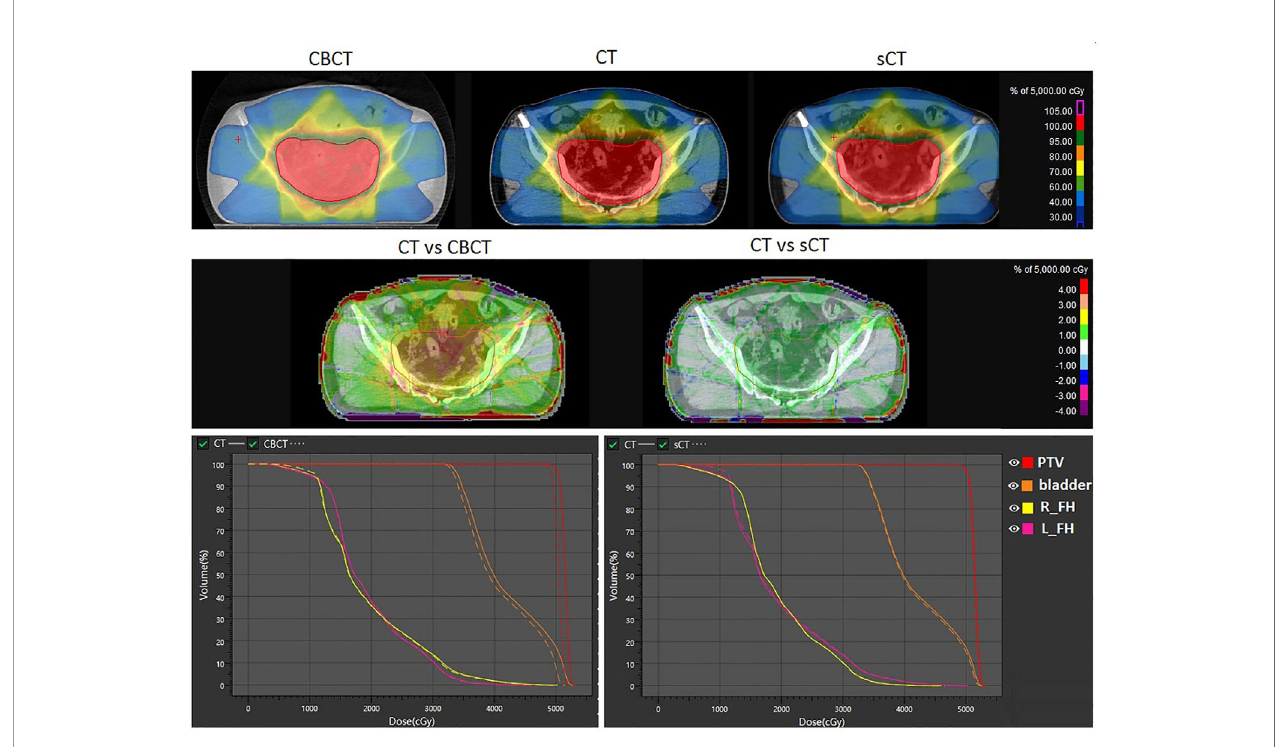
FIGURE 6 | Dosimetric comparison of the same plan calculated on CBCT, sCT and CT. The fi rst row shows the dose distribution on CBCT, CT and sCT. The second row shows the dose distribution differences. The third row shows the DVH differences. L_FH and R_FH means left femoral head and right femoral